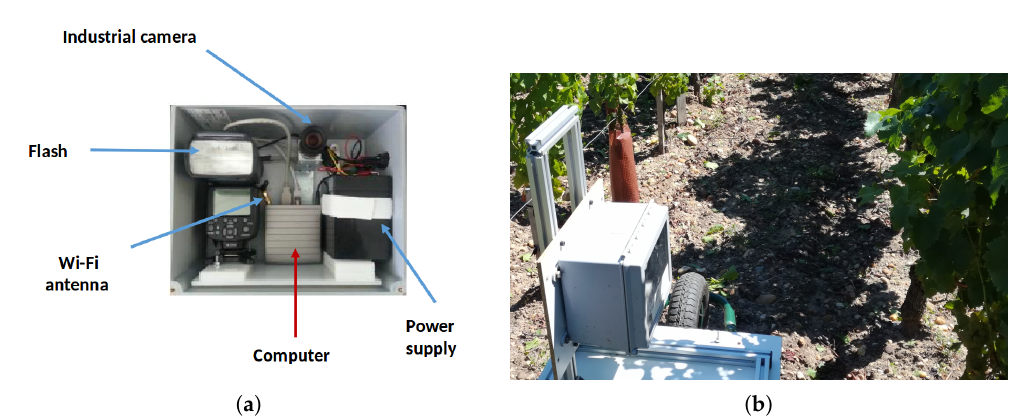
Figure 3. ( a ) Detailed view of the sensor; and ( b ) sensor progressing through a vineyard row.